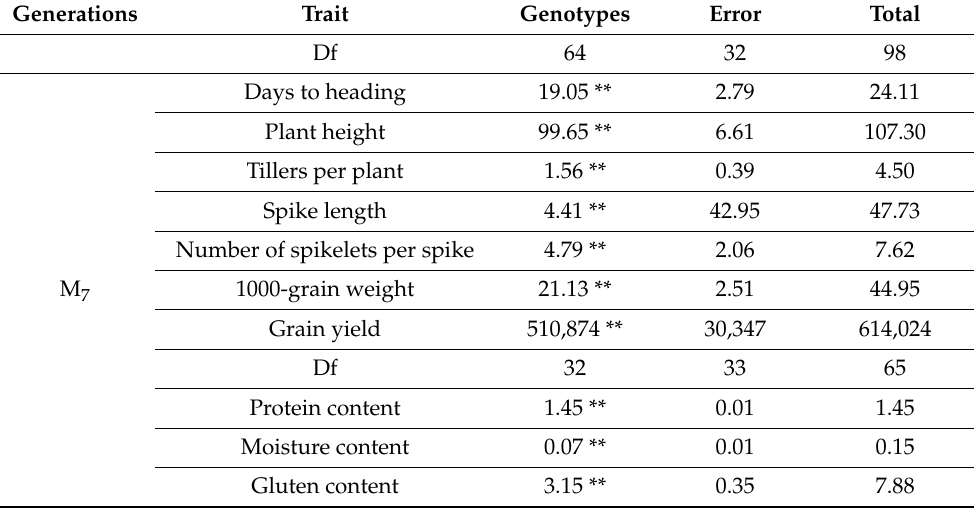
Table 1. Mean square values for all traits of 32 mutant lines and the wild type in M 7 and M 8 generations at the NIBGE